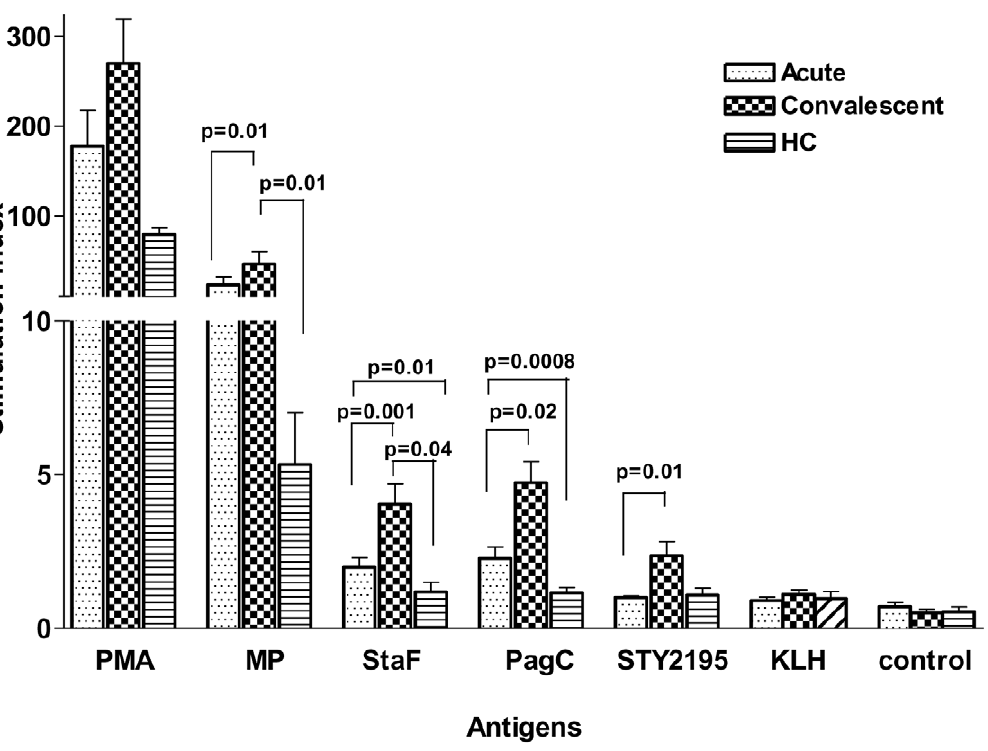
Figure 3. Cellular proliferation responses to S . Typhi antigens including StaF (STY0202), PagC (STY1878), conserved hypothetical protein encoded by STY2195, S . Typhi membrane preparation (MP), control protein, and phytohaemagglutinin (PHA) and keyhole limpet hemocyanin (KLH) during acute and convalescent stage illness in S . Typhi bacteremic patients and in healthy controls (HC). Stimulation index: net cpm with antigen /net cpm without antigen (media alone) for each individual on each day (acute and convalescent). Mean and standard error of the mean represented.